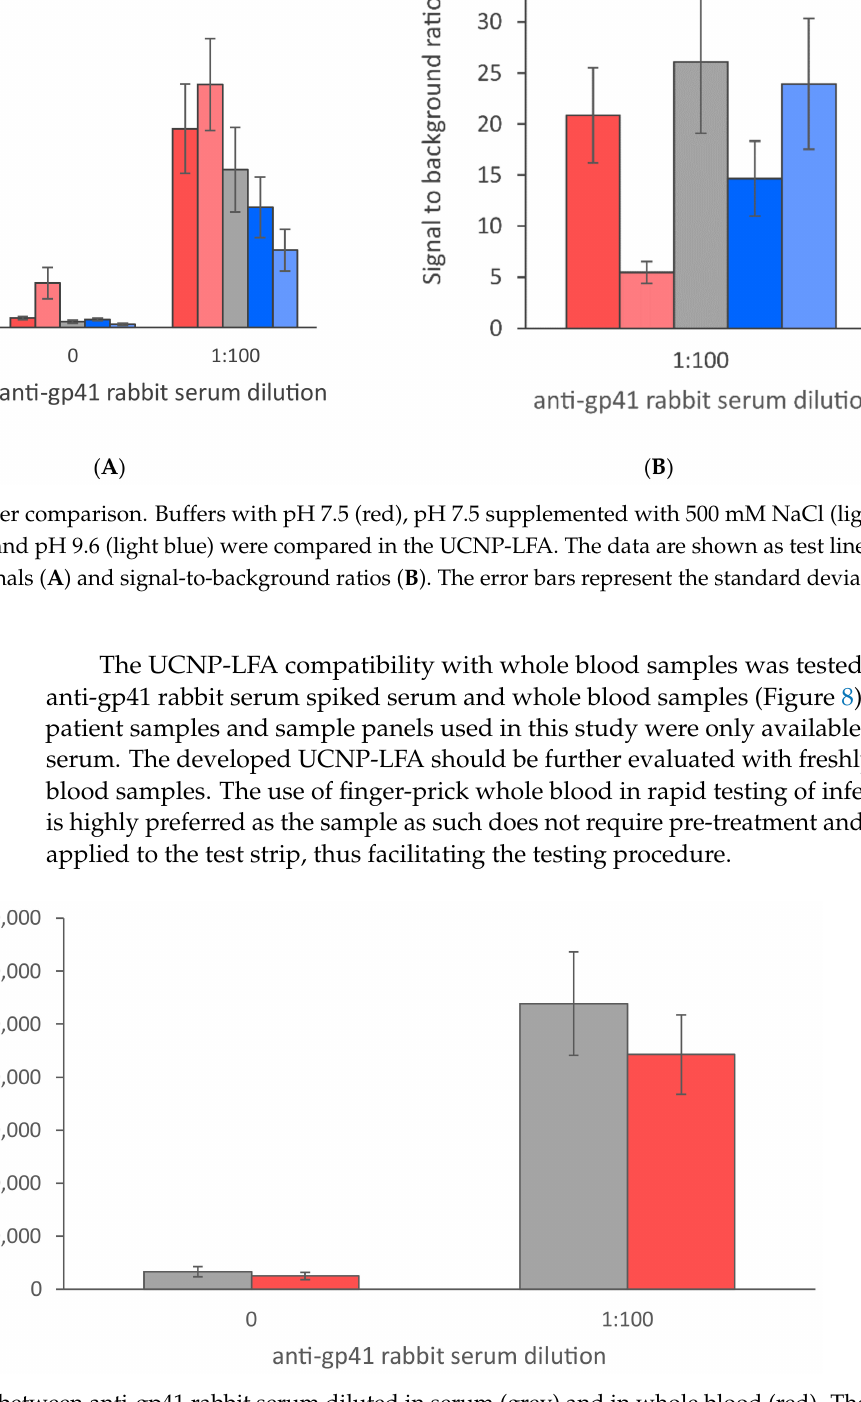
Figure 8. Comparison between anti-gp41 rabbit serum diluted in serum (grey) and in whole blood (red). The error bars represent the standard deviation among three replicate